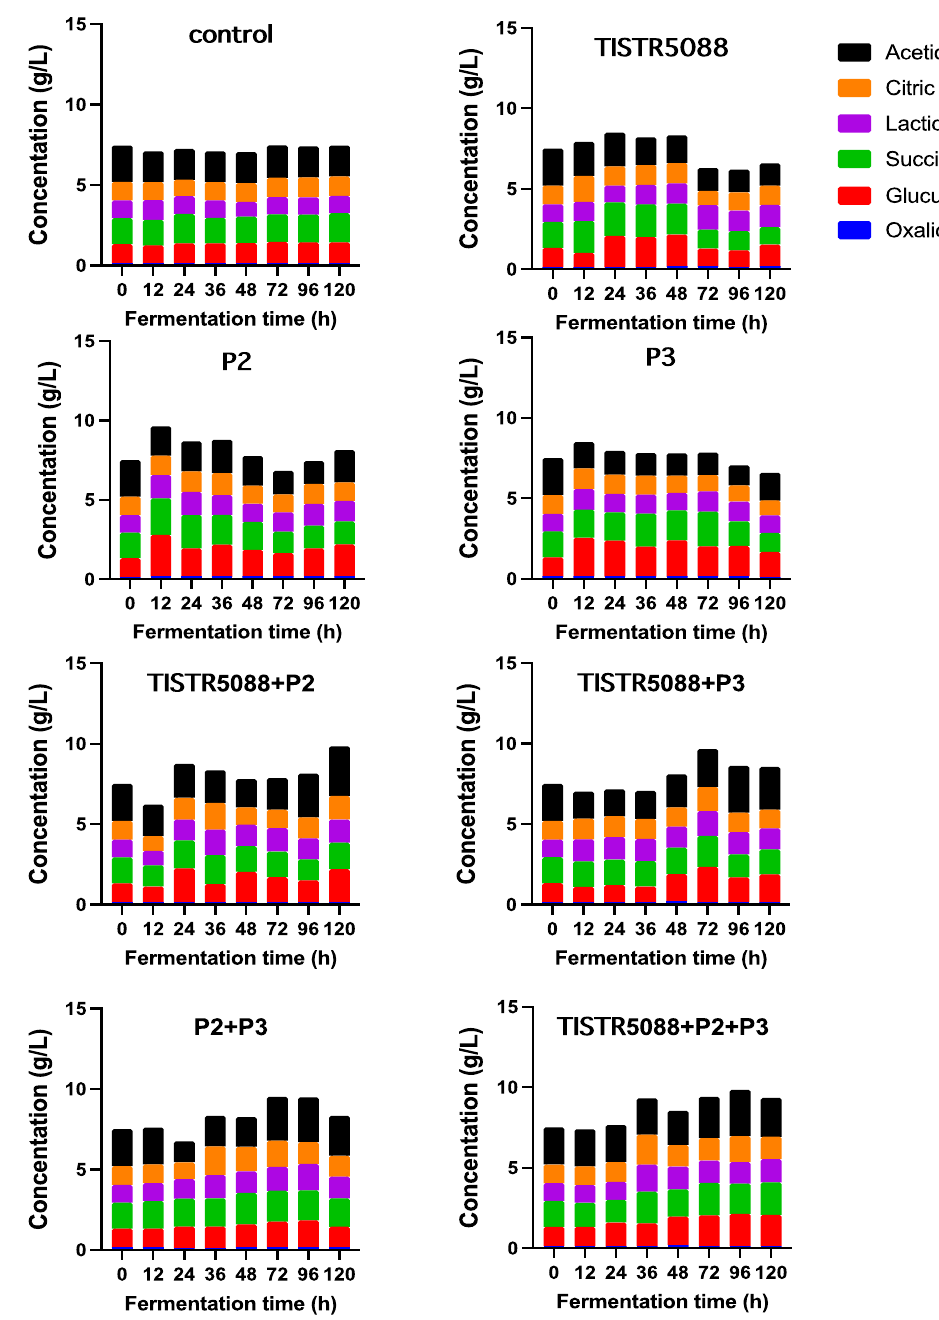
Figure 6. Organic acid profiles during fermentation of MF-broth fermented by S. cerevisiae TISTR 5088, W. anomalus P2 and C. rhodanensis P3, with single and co-fermentation at 30 °C for 120 h.